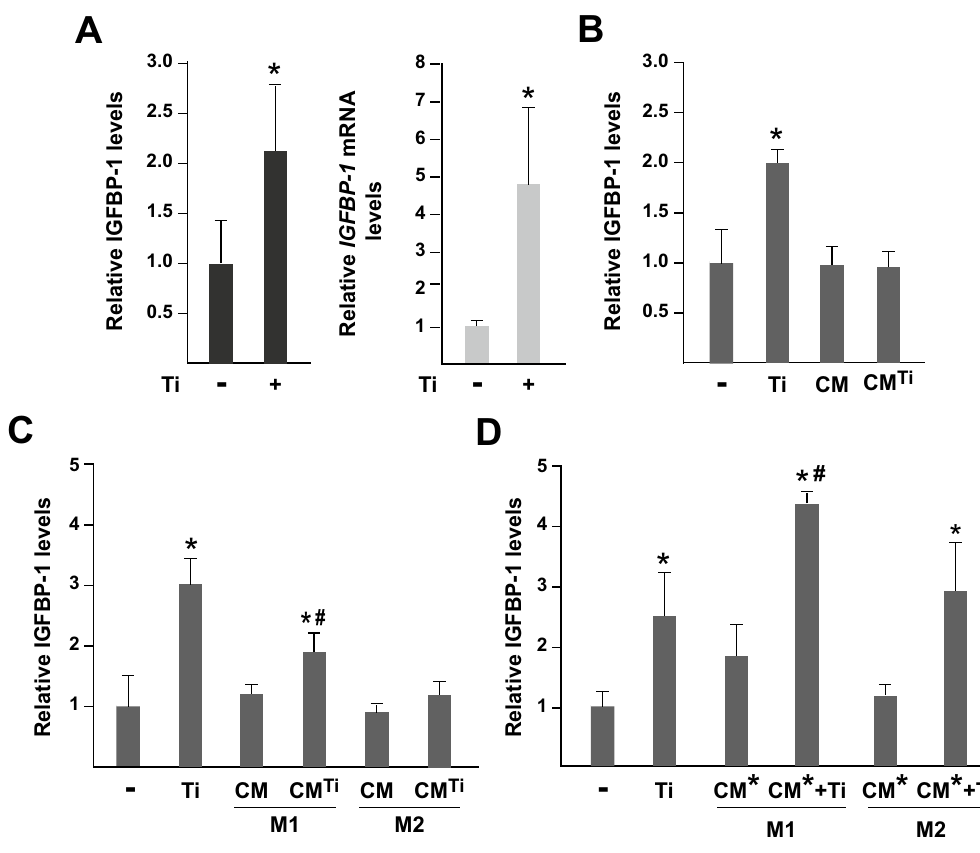
Figure 5. IGFBP-1 production by primary cultures of human osteoblasts. ( A ) IGFBP-1 secretion (left panel) and IGFBP1 mRNA levels (right panel) in osteoblasts exposed (+) or not (−) to 5 mg/mL of titanium (Ti) particles for 24 h. ( B – D ) IGFBP-1 secretion in osteoblasts incubated for 24 h in conditioned media from osteoblasts exposed (CM Ti ) or not (CM) to 5 mg/mL of Ti particles ( B ); in conditioned media from M1 and M2 macrophages exposed (CM Ti ) or not (CM) to 5 mg/mL of Ti particles ( C ); and in conditioned media from pre-activated, LPS-treated M1 or M2 macrophages containing (CM* + Ti) or not (CM*) 5 mg/mL of Ti particles ( D ). Data are presented as mean + SD and expressed as relative fold induction to levels in untreated osteoblasts, which were given the arbitrary value of 1. These levels corresponded to 6.36 pg IGFBP-1 in ( A ), 6.18 pg of IGFBP-1 in ( B ), 4.99 pg in ( C ) and 5.45 pg in ( D ) per µg of total proteins. * p < 0.05 as compared with osteoblasts not exposed to particles, and # p < 0.05 as compared with Ti-treated osteoblasts not incubated in conditioned